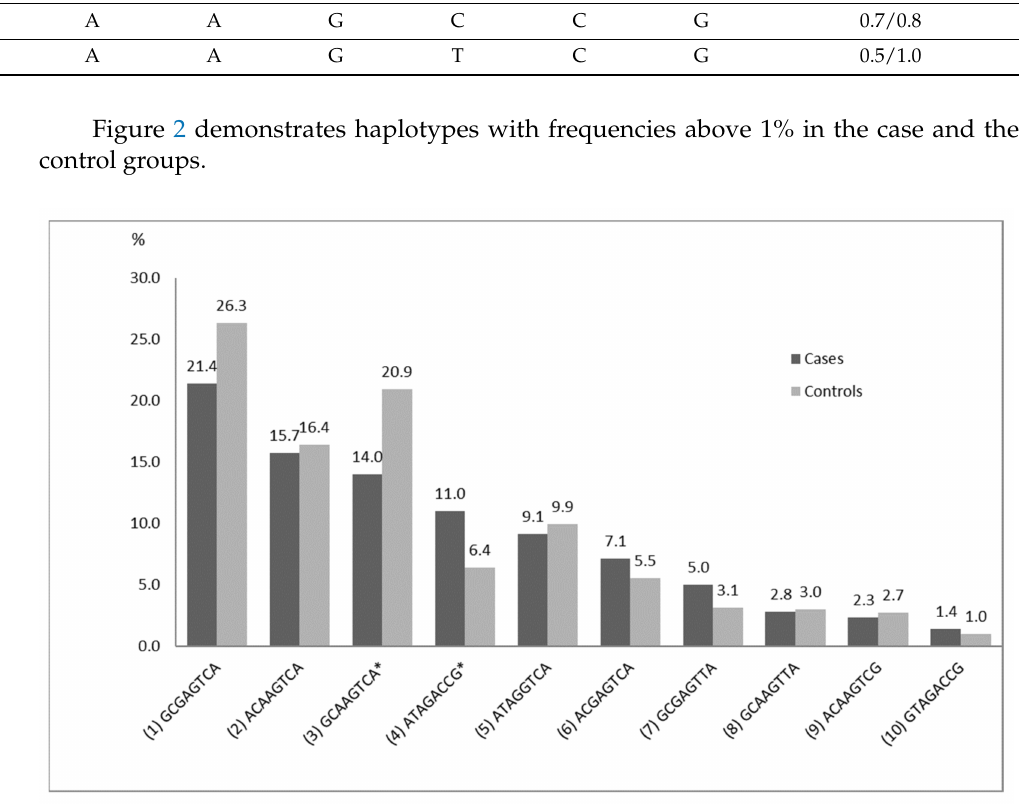
Figure 2. Haplotype frequencies for the LOAD patients and the control group. * Statistically significant differences between the cases and the controls ( p <